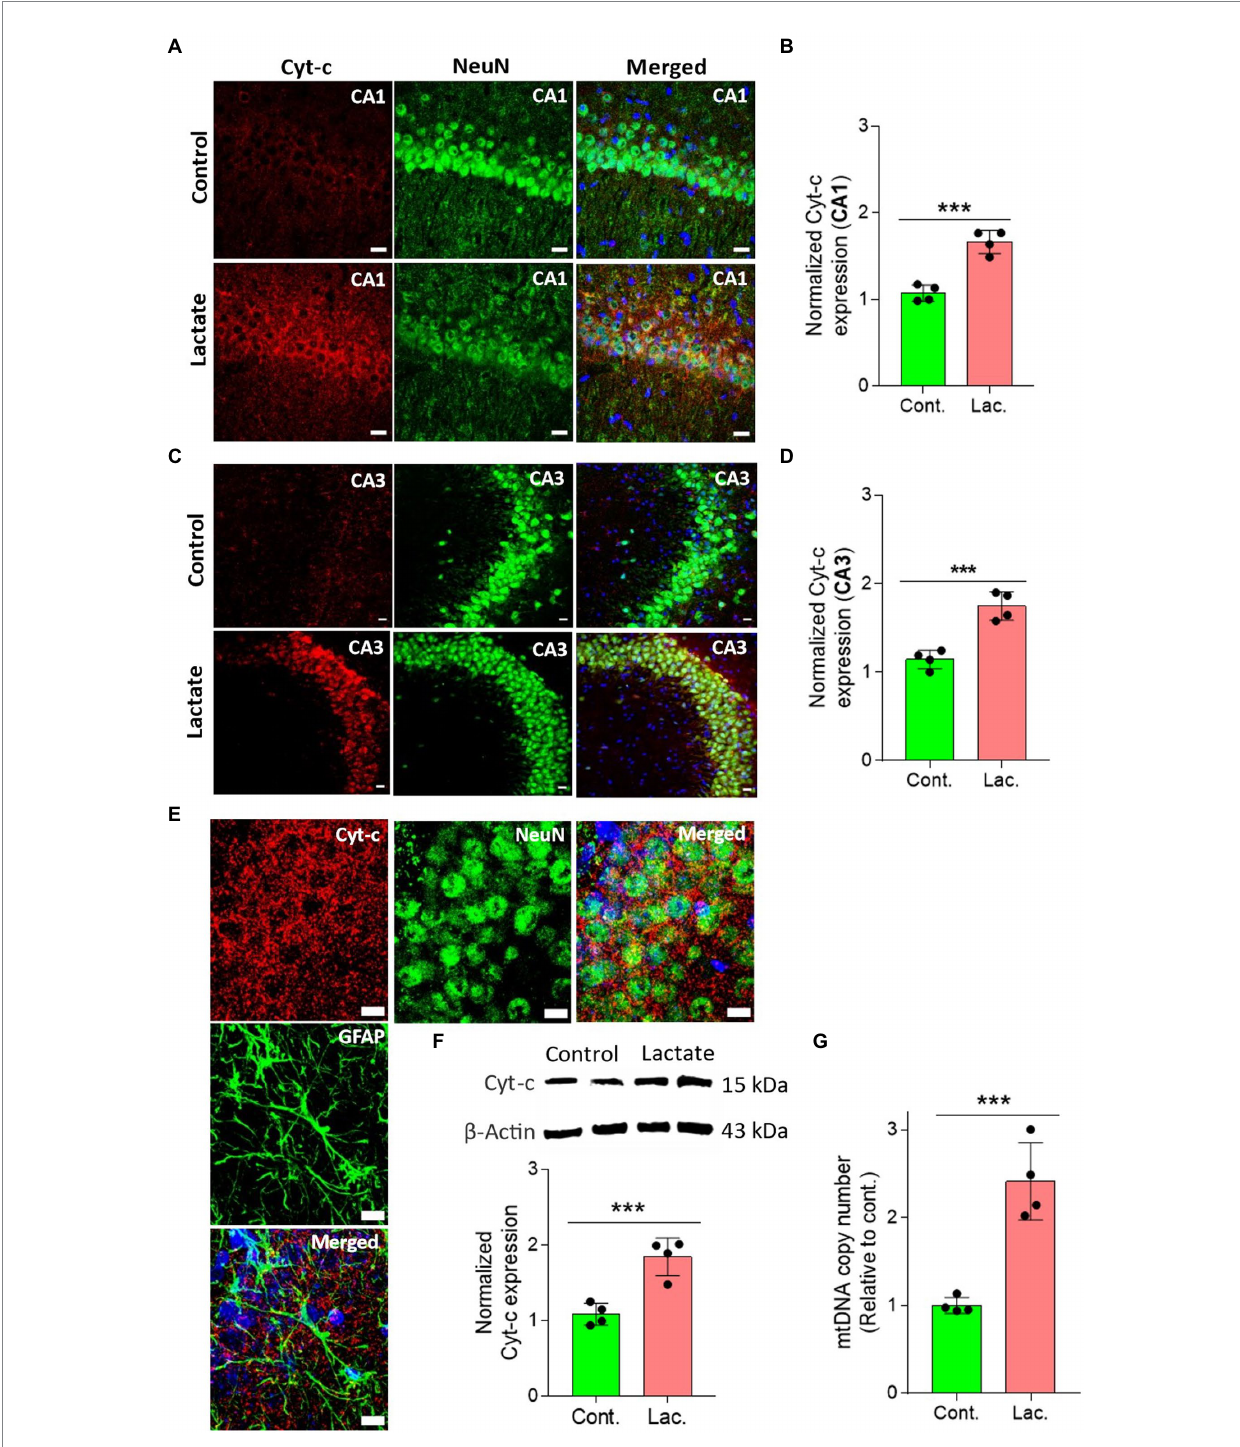
FIGURE 6 L-lactate increases Cyt-c expression in neuron of HPC and increases mtDNA copy number. (A,C) Representative confocal micrograph of Cyt-c (red) co-labelled with NeuN (green) in the CA1 (A) and CA3 (C) areas of HPC of control and lactate groups. L-lactate infusion increased Cyt-c expression in both areas of HPC. Scale bars: 20 μ m. (B,D) Fluorescence intensity of Cyt-c-stained sections in the CA1 (B) and CA3 (D) areas of HPC of lactate group was assessed and normalized to control group. Data are shown as mean ± SD ( n = 4 rats per group). p *** < 0.001, unpaired Student’s t -test. (E) Representative confocal micrograph of Cyt-c (red) co-labelled with GFAP (green) or NeuN (green) in the HPC of lactate group. Scale bars: 10 μ m. (F) Representative WB images of Cyt-c in the HPC extracts from control and lactate groups. Intensity of Cyt-c was quantified and normalized with β -actin. Cyt-c was found to be significantly increased in lactate group compared to control. Data are shown as mean ± SD ( n = 4 rats per group). p *** < 0.001, unpaired Student’s t -test. (G) mtDNA copy number abundance in the HPC of control and lactate groups relative to nDNA. Relative mtDNA copy number was significantly increased in lactate group compared to control. Data are shown as mean ± SD ( n = 4 rats per group). p *** < 0.001, unpaired Student’s t